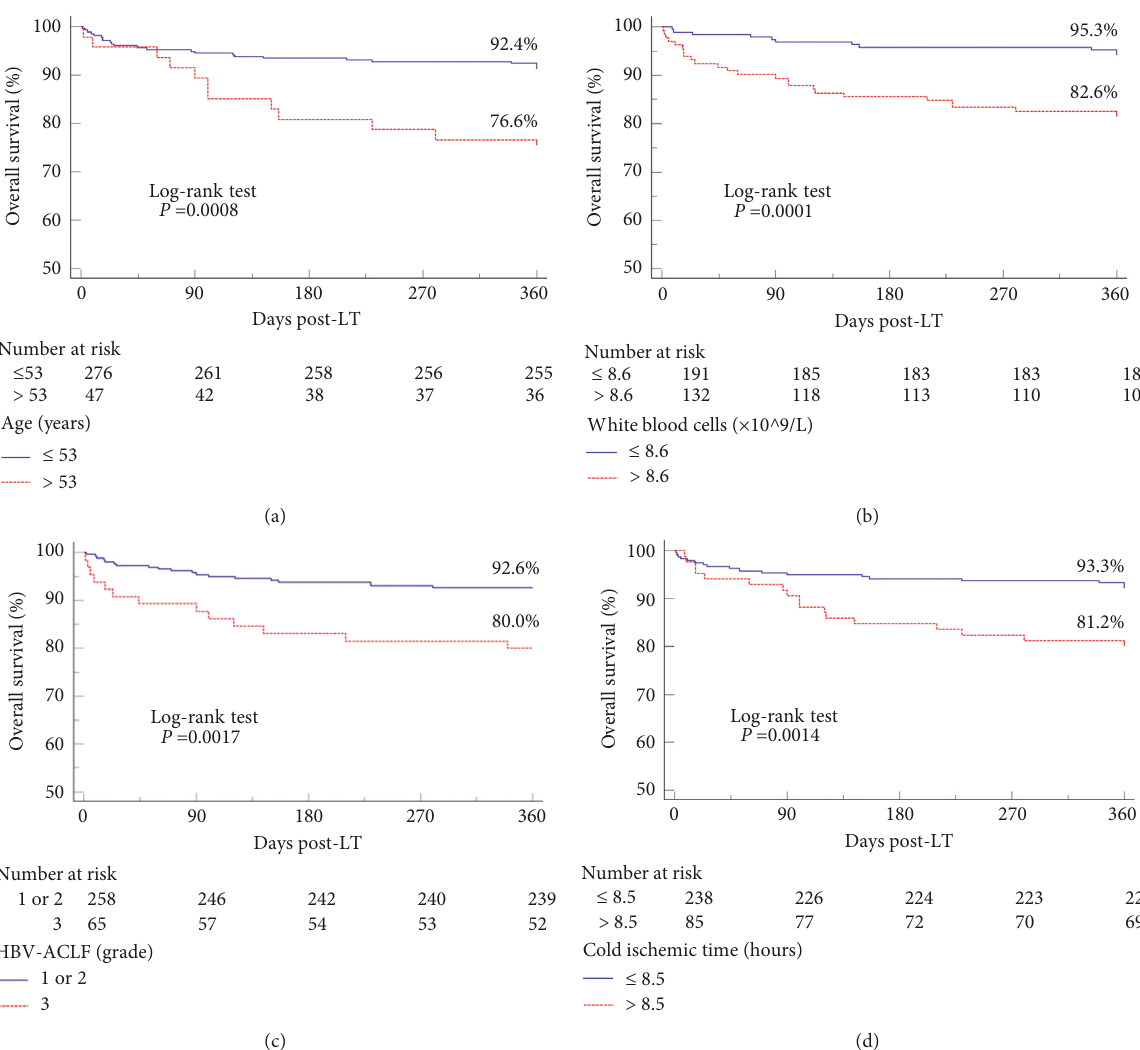
Figure 4: Kaplan–Meier analyses of 1-year survival rates in recipients with HBV-ACLF (a) aged > 53 years (vs. ≤ 53 years), (b) WBC counts > 8.6 × 109/L (vs. ≤ 8.6 × 109/L), (c) HBV-ACLF grade 3 (vs. HBV-ACLF grades 1 and 2), and (d) cold ischaemia time > 8.5 hours (vs. ≤ 8.5 hours) ( p < 0 .